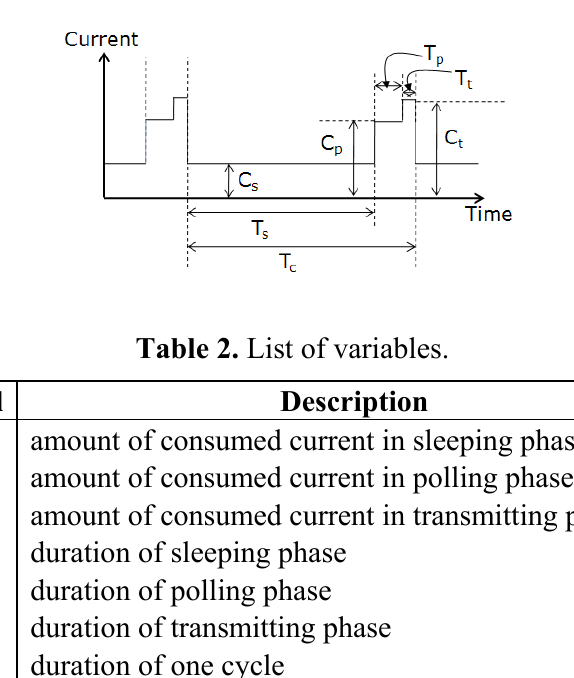
Figure 7. Approximation of energy consumption phases.